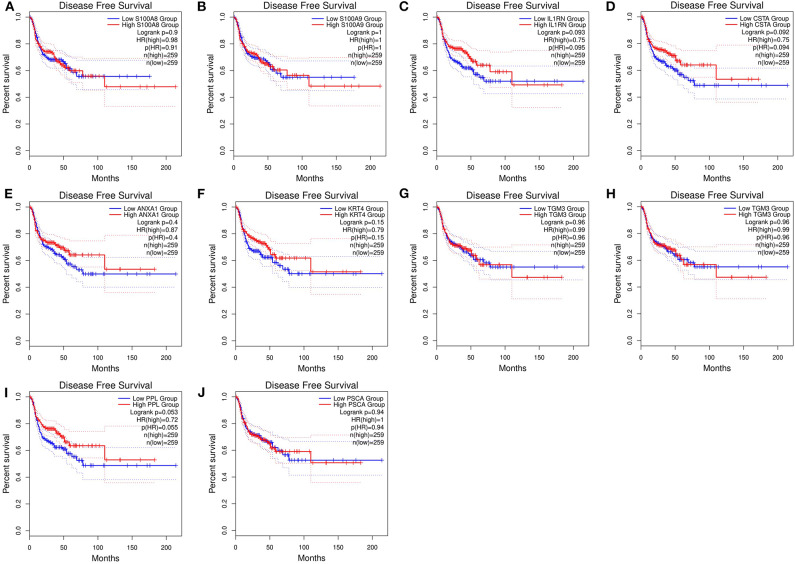
Disease-free survival (DFS) analysis of 10 hub genes in HNSCC patients from the GEPIA2 database. (A) Survival analysis for S100A8 in HNSCC. (B) Survival analysis for S100A9 in HNSCC. (C) Survival analysis for IL1RN in HNSCC. (D) Survival analysis for CSTA in HNSCC. (E) Survival analysis for ANXA1 in HNSCC. (F) Survival analysis for KRT4 in HNSCC. (G) Survival analysis for TGM3 in HNSCC. (H) Survival analysis for SCEL in HNSCC. (I) Survival analysis for PPL in HNSCC. (J) Survival analysis for PSCA in HNSCC. The patients were stratified into high-level group (red) and low-level group (green) according to median expression of the gene. Log-rank P < 0.05 was considered to be a statistically significant difference.